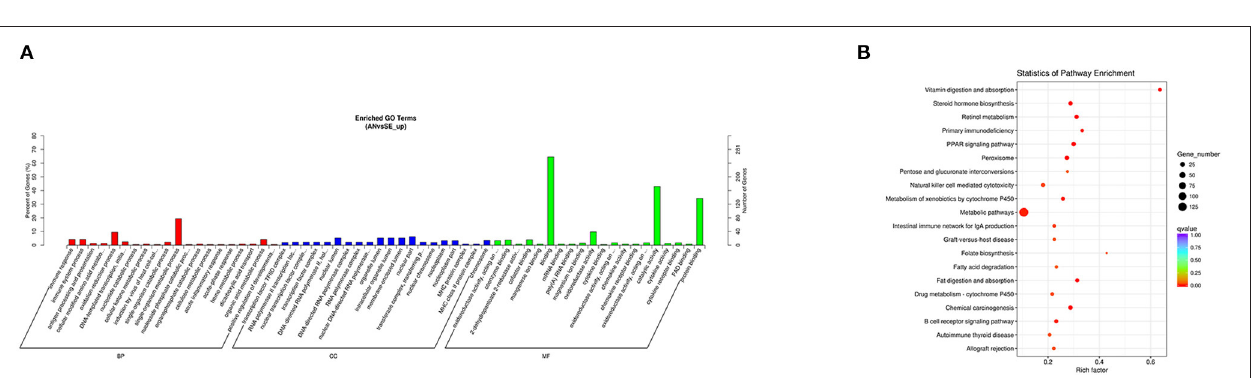
FIGURE 7 | Top annotated GO terms (A) and KEGG pathways (B) of trans-target genes of upregulated DE